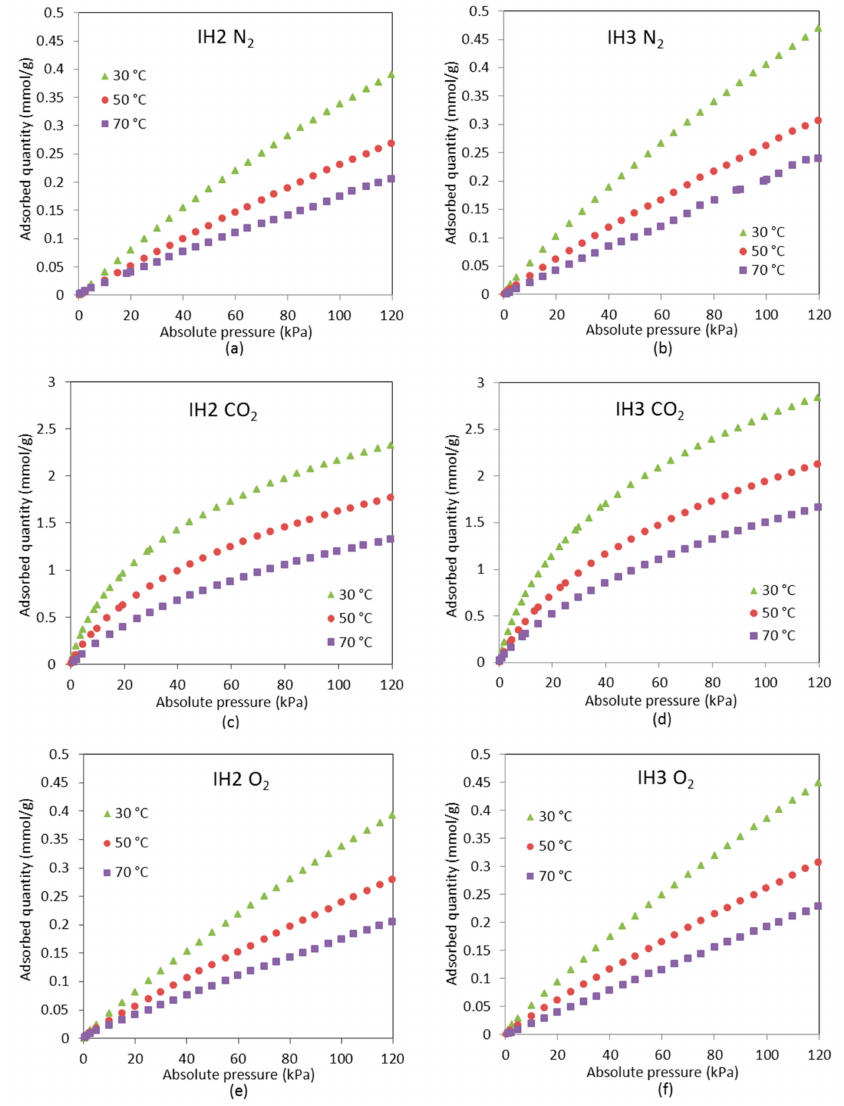
Figure 2. N 2 ( a , b ); CO 2 ( c , d ); and O 2 ( e , f ) adsorption isotherms at 30, 50, and 70 ◦ C up to 120 kPa on samples IH2 and